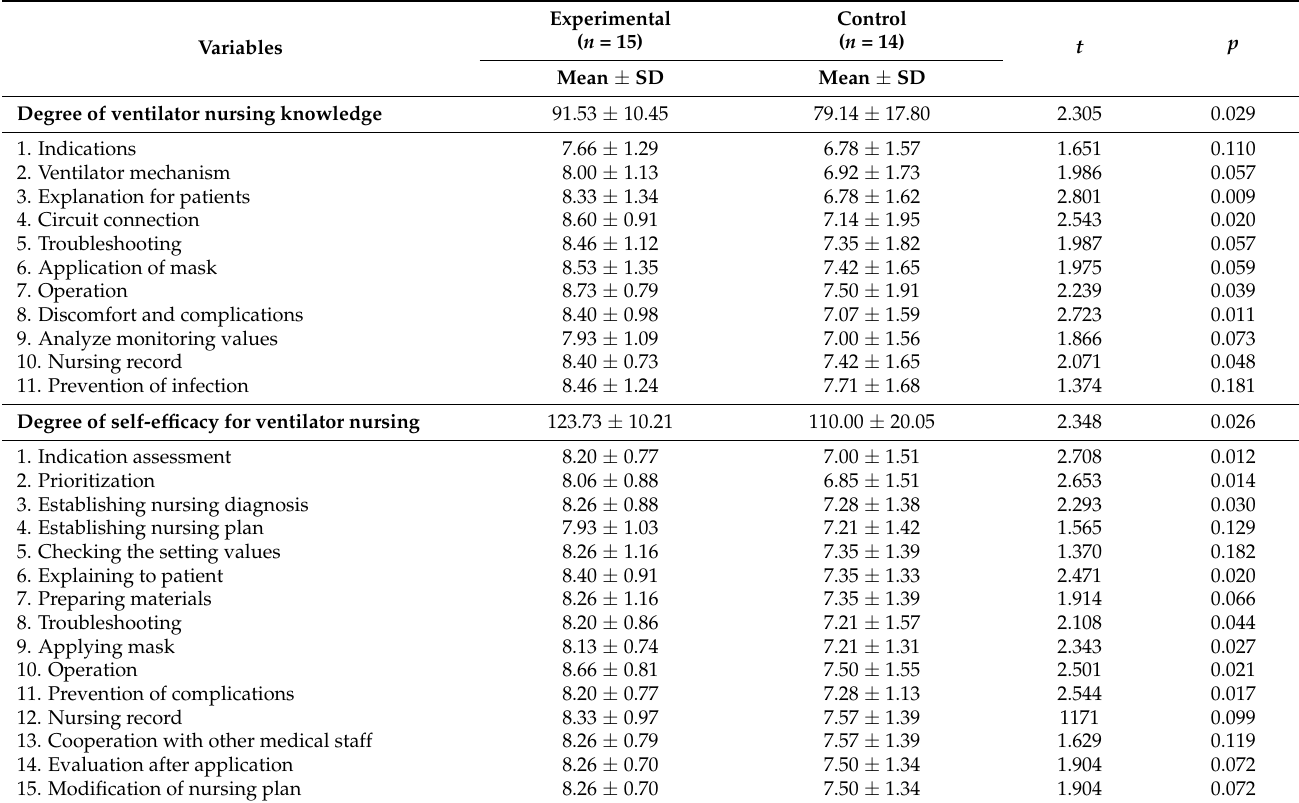
Table 3. Changes in the participants’ knowledge and